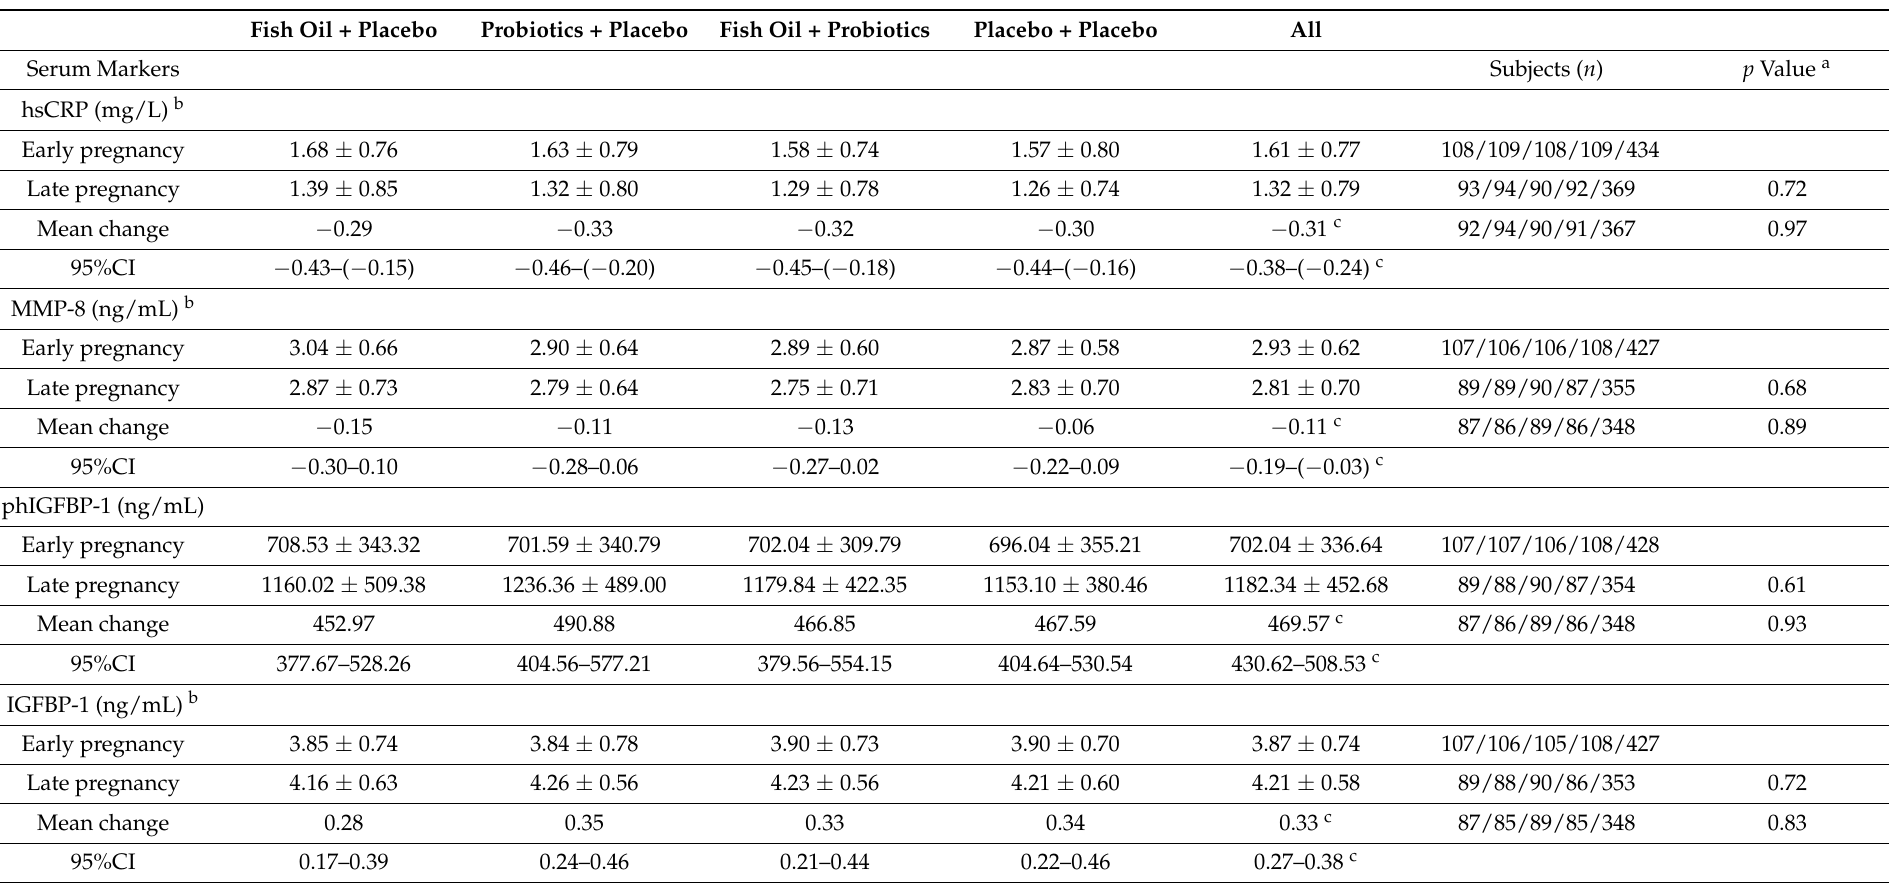
Table 1. The concentrations of early and late pregnancy serum high sensitivity C-reactive protein (hsCRP), matrix metalloproteinase 8 (MMP-8), phosphorylated insulin-like growth factor binding-protein 1 (phIGFBP-1), IGFBP-1 and vaginal MMP-8 in the different intervention groups and in all of the women. Data are expressed as mean ± SD and 95% Confidence Intervals for mean change